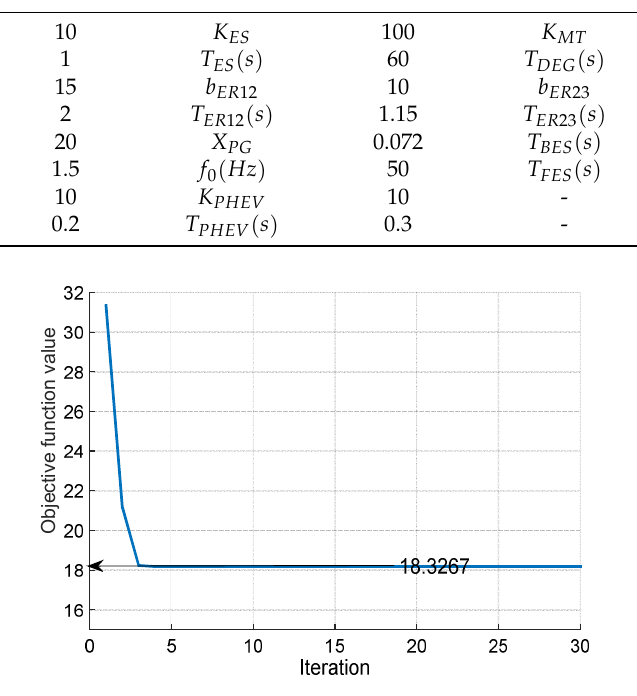
Figure 7. Objective function value.